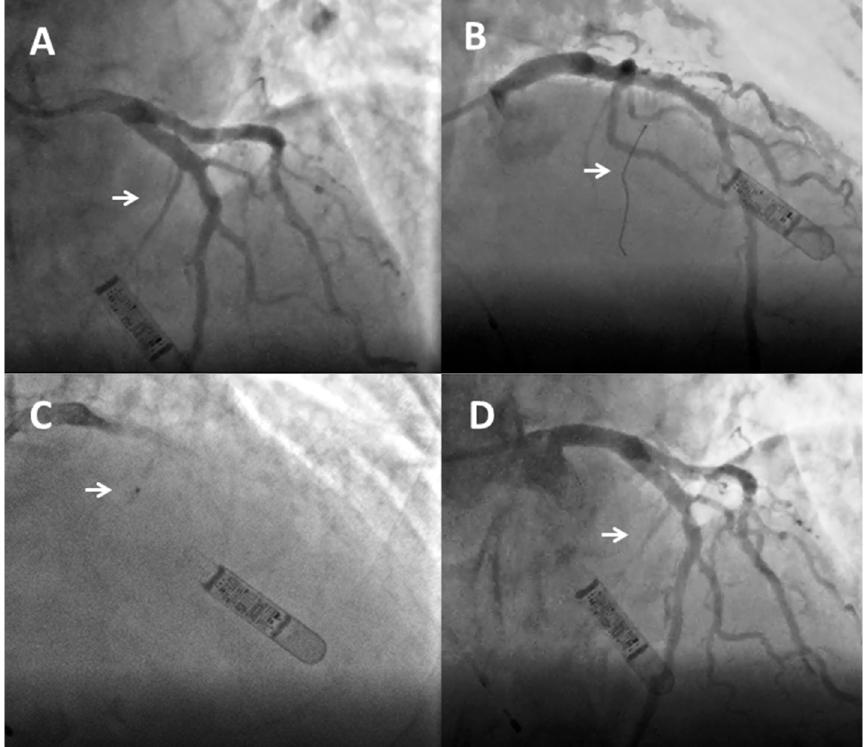
Figure 1. Angiographic sequence of alcohol septal ablation. ( A ) Baseline angiogram of the left coronary artery with estimated target septal branch (arrow). ( B ) Wiring of the target septal branch (arrow). ( C ) Injection of angiographic contrast media through the lumen of the over-the-wire balloon (arrow). ( D ) Occlusion of the distal portion of the septal branch (arrow) after balloon retraction 10 min after the last alcohol injection without damage to the left anterior descending artery.